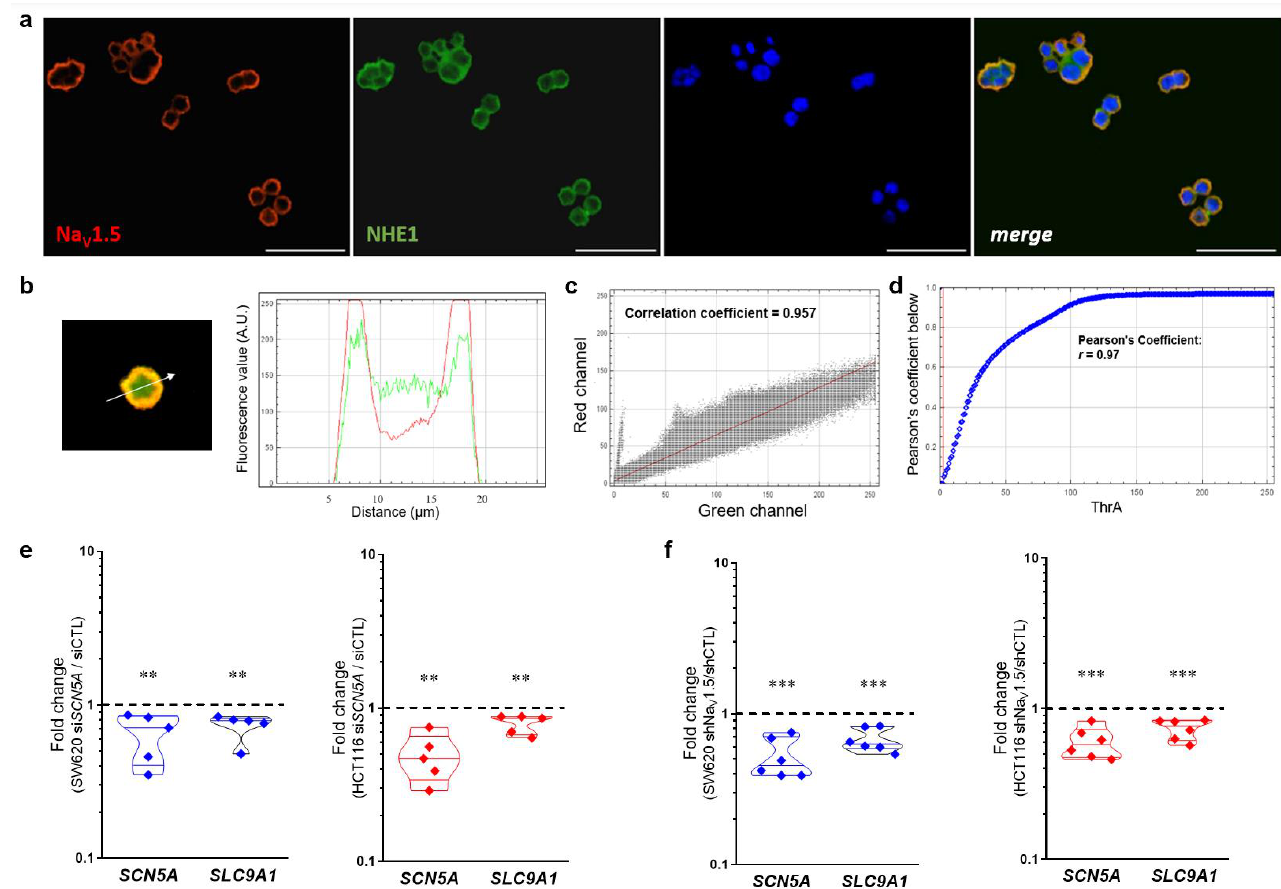
Figure 7. Colocalization analysis of Na V 1.5 and NHE-1 proteins and regulation of SLC9A1 transcript expression by Na V 1.5 sodium channels. ( a ) Epifluorescence microscopy analysis of Na V 1.5 and NHE-1 proteins in SW620 cells. Images show the staining for Na V 1.5 proteins (red, detected with the Anti-Sodium Channel Na V 1.5 antibody produced in rabbit Sigma-Aldrich Ref. S0819), NHE-1 (green, detected with the antibody anti-NHE-1 Santa Cruz Biotechnologies Ref. sc-136239), nuclei (blue, DAPI) and the merge image. Both proteins Na V 1.5 and NHE-1 are located at the plasma membrane of cancer cells. Scale bar 50 µm. ( b ) A representative example of merging the green and red channels of the epifluorescence images is shown. The right panel shows the fluorescence profile for the two channels along the linear segmentation indicated by the white arrow. ( c ) Cytofluorogram for the fluorescence signals and spatial distribution corresponding to Na V 1.5 and NHE-1 proteins from images shown in ( a ). ( d ) Plot shows Costes’ automatic threshold analysis of the red and green channels of the images displayed in ( a ), provided a Pearson coefficient of r = 0.97. ( e ) Violin plots show the relative SCN5A and SLC9A1 gene expression in SW620 (left) and HCT116 (right) cells transfected with si SCN5A ** p < 0.01 vs. siCTL Mann – Whitney rank sum tests. ( f ) Relative SCN5A and SLC9A1 gene expression in shNa V 1.5 cell lines derived from SW620 (left) and HCT116 (right) cells. Relative analysis was carried out using the shCTL (null-target shRNA) cell lines *** p < 0.001 vs. shCTL cell line Mann – Whitney rank sum tests.